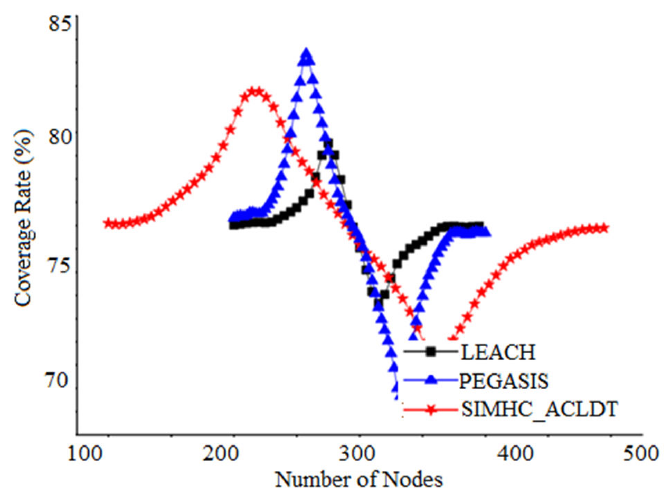
Figure 3. Comparative analysis of average delay.